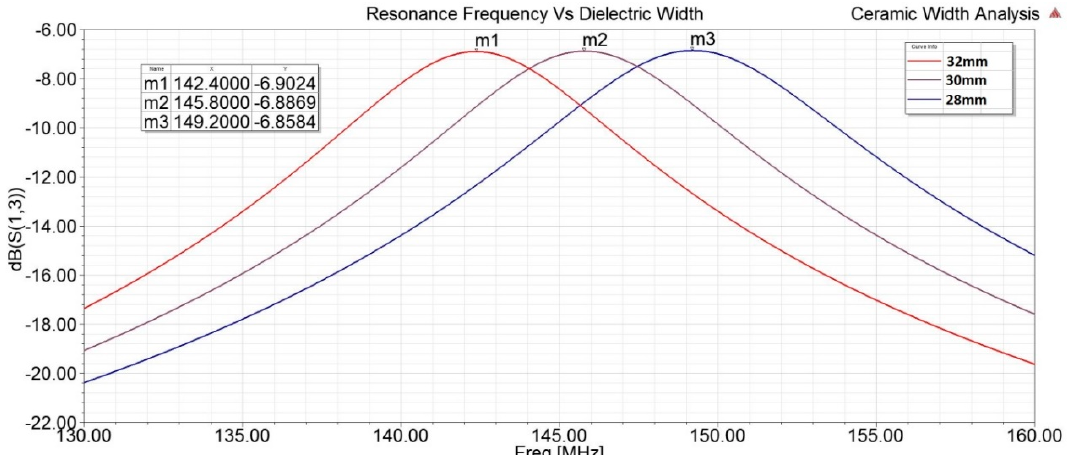
Figure 7. Simulation results for the resonance frequency as a function of the ceramic width. Markers represent the resonance frequency and the signal coupling to beam entry port for different pickup positions.